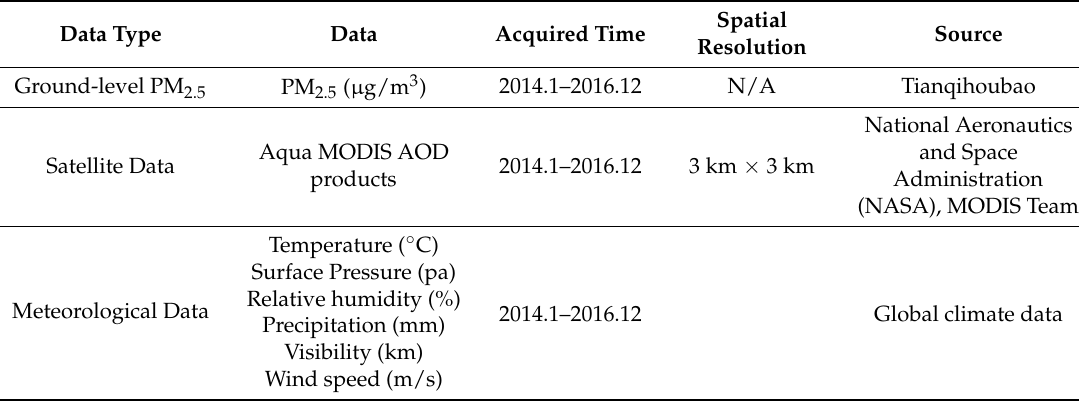
Table 1. Data sets used in this study. AOD: aerosol optical